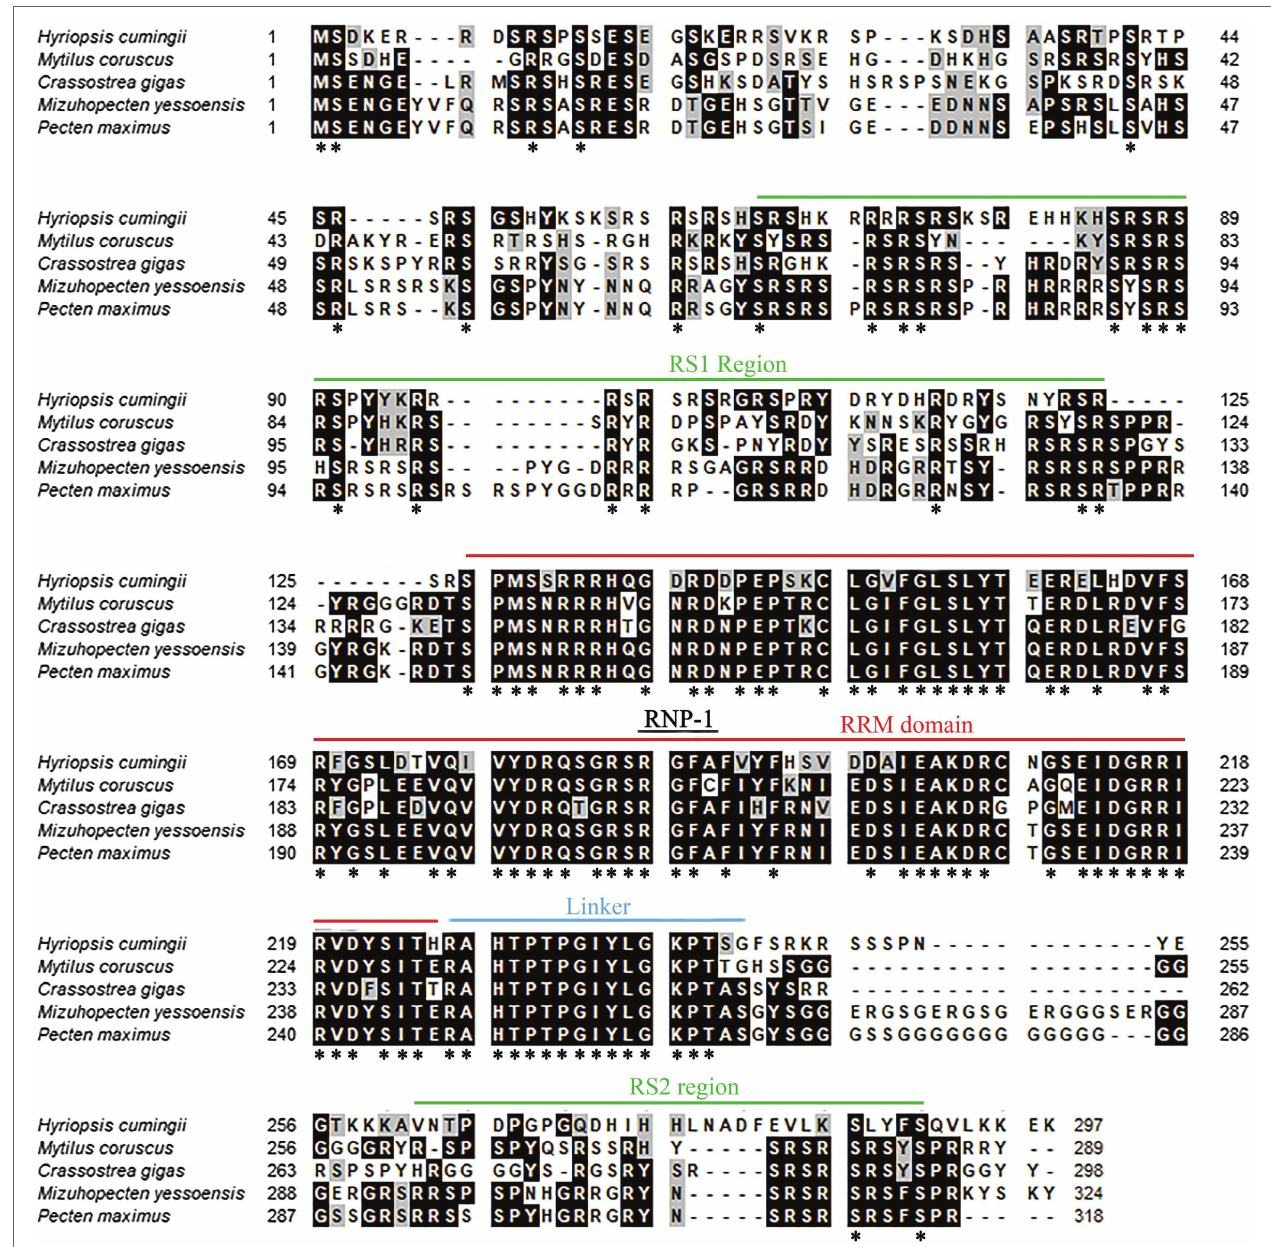
FIGURE 2 | Multiple alignment of Hctra-2 amino acid sequence from H. cumingii with other species. Identical amino acid residues are highlighted in black, and similar amino acids are highlighted in gray. * Means that the amino acids at this site are the same in all the species